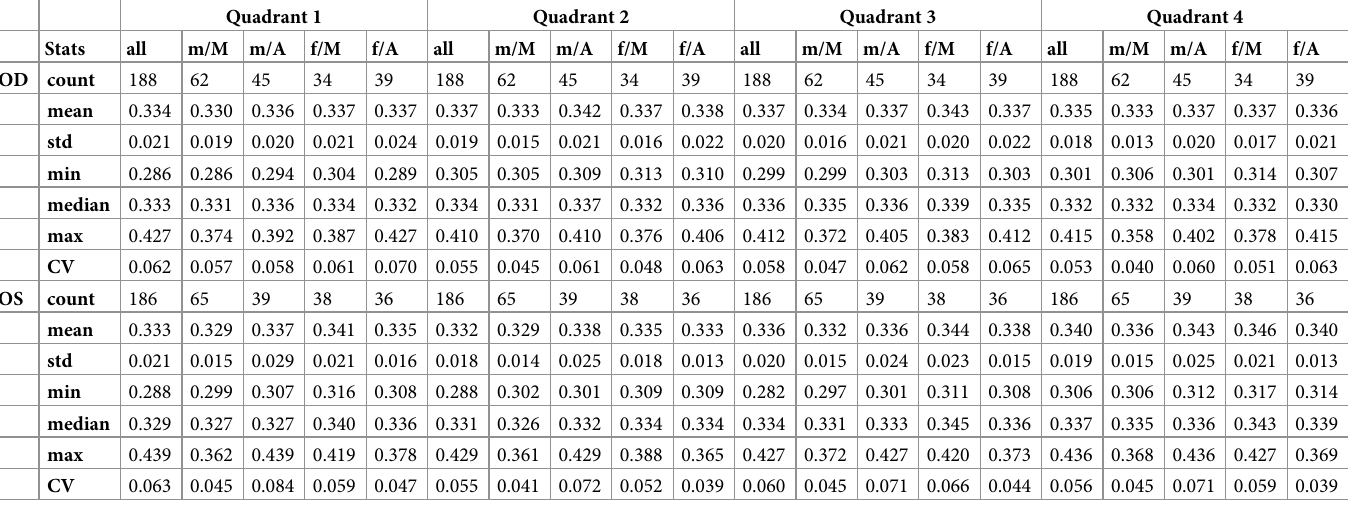
Table 2. Summary presentation of the choroid volume quadrant values male compared to female monkeys and origin.